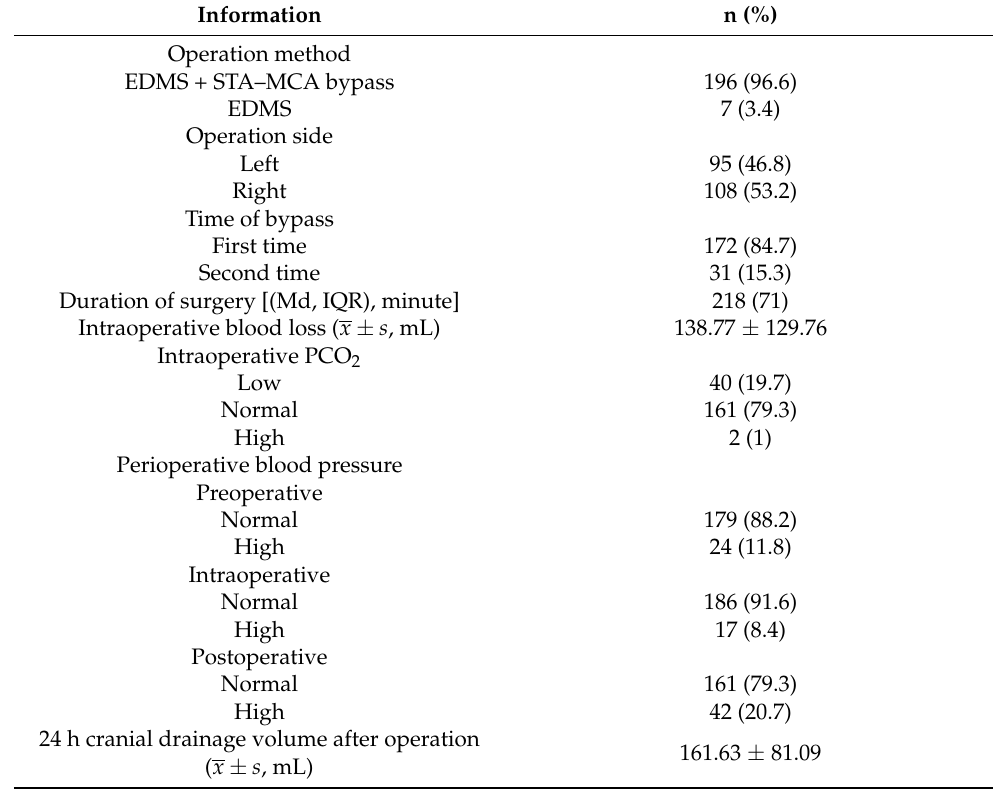
Table 2. Surgical information of 203 cases of revascularization of